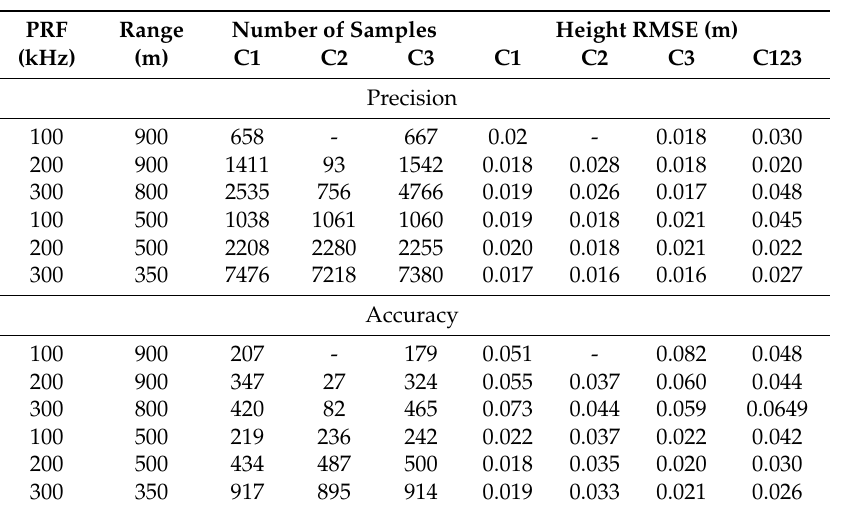
Table 10. Results from a precision and accuracy assessment of height values for different system PRFs at the middle of the sensor operational flying height envelope.